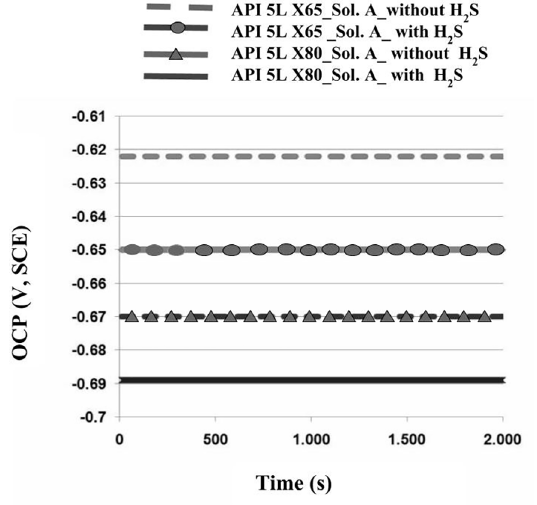
Figure 5. OCP variation for the API 5L X65 and API 5L X80 steels in deaerated solution A, NACE TM0284 (2011), without and with H S saturation. Experimental Procedure 2